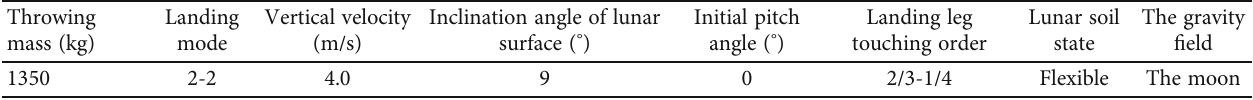
Table 2: Work condition of soft-landing simulation